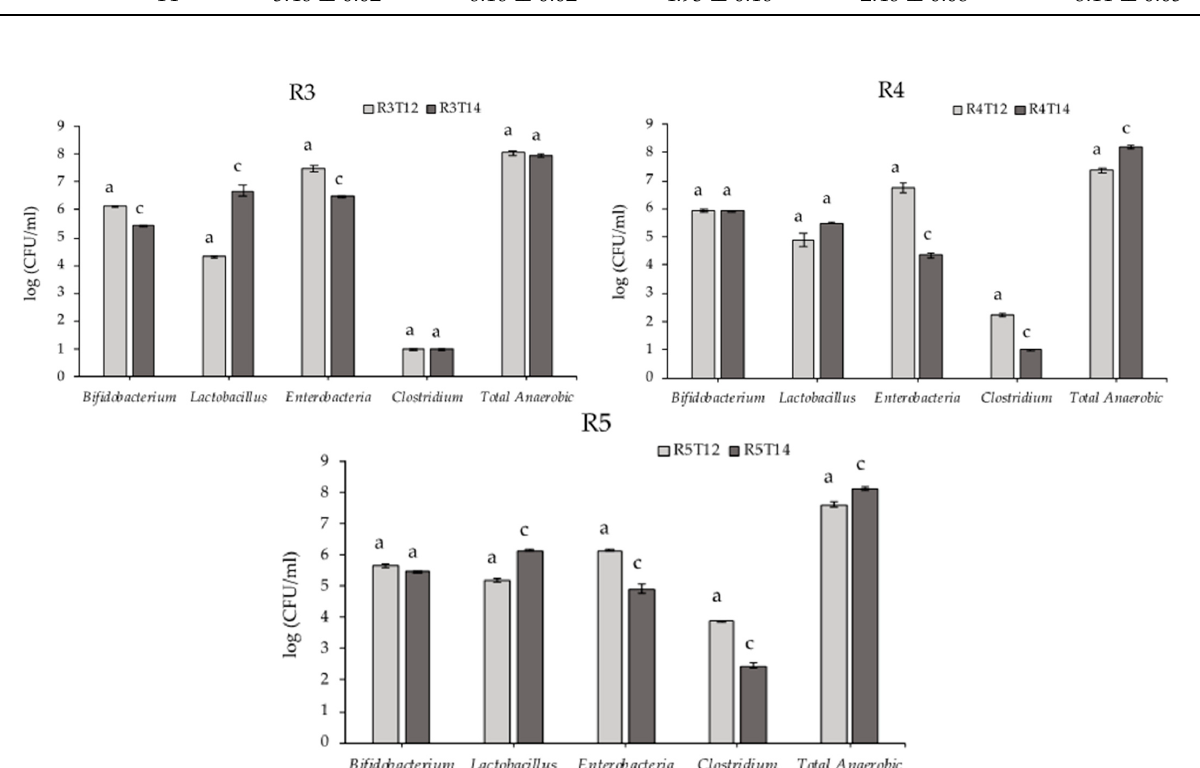
Figure 1. Microbiological count of the three colonic reactors: ( R3 , R4 and R5 ) before (T12) and after the treatment (T14) ( n = 2 ± SD). A Mann–Whitney U Test was applied for differences between two groups on a single, ordinal variable with no specific distribution. Different letters mean statistically significant differences: a, no significant difference ( p > 0.05) and c, for a very significant difference ( p < 0.025). Results are shown as log (CFU/mL).